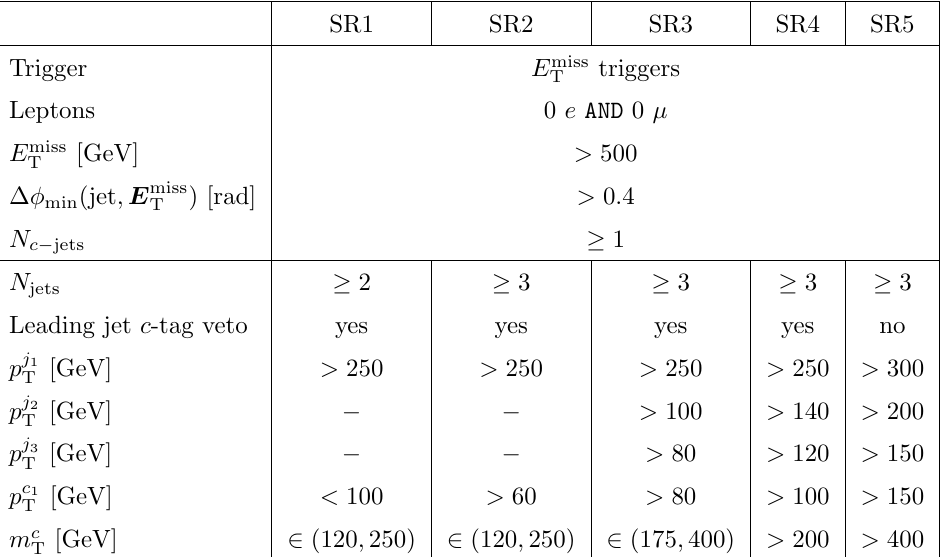
Table 1 . Overview of the signal region selection criteria. N jets and N c (cid:0) jets indicate the total number of jets and c -jets, respectively; p j 1 leading, sub-leading and sub-sub-leading jet; and p c 1 the highest p T